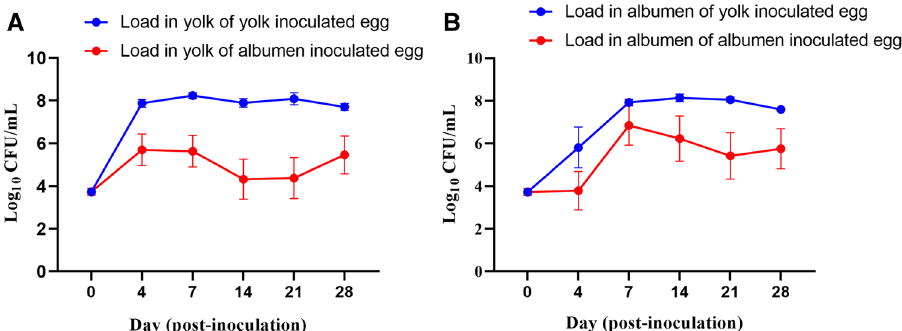
Figure 1. Load of Salmonella Typhimurium in yolk or albumen inoculated eggs stored at 25 °C. ( A ) Load in yolk of yolk and albumen inoculated eggs. ( B ) Load in albumen of yolk and albumen inoculated eggs. At each sampling time-point, 3 eggs from each treatment group were processed for the quantification of Salmonella Typhimurium load through direct plating on XLD media plates. At day 0, each egg was inoculated with 10 3 CFU/0.1 mL of Salmonella Typhimurium directly injected to either yolk or albumen.